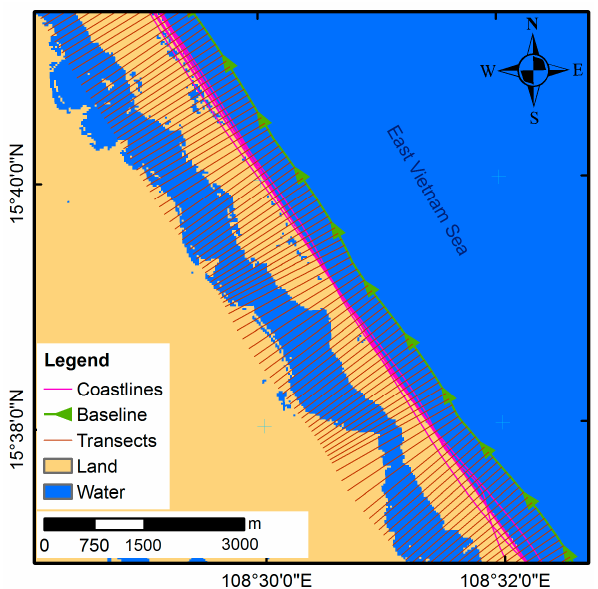
Figure 9. A 2019 example of the baseline and transects at the red-box in Figure 8 along the Quang Nam coast.